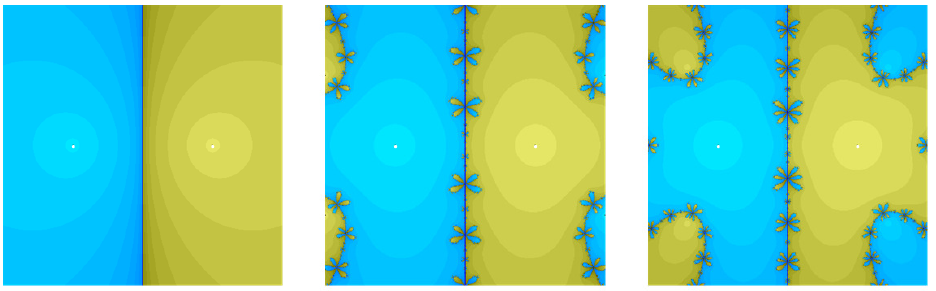
Figure 1. Attraction basins for Equation (7) on the left, Padé 0–3 in middle and Padé 0–4 to the right.